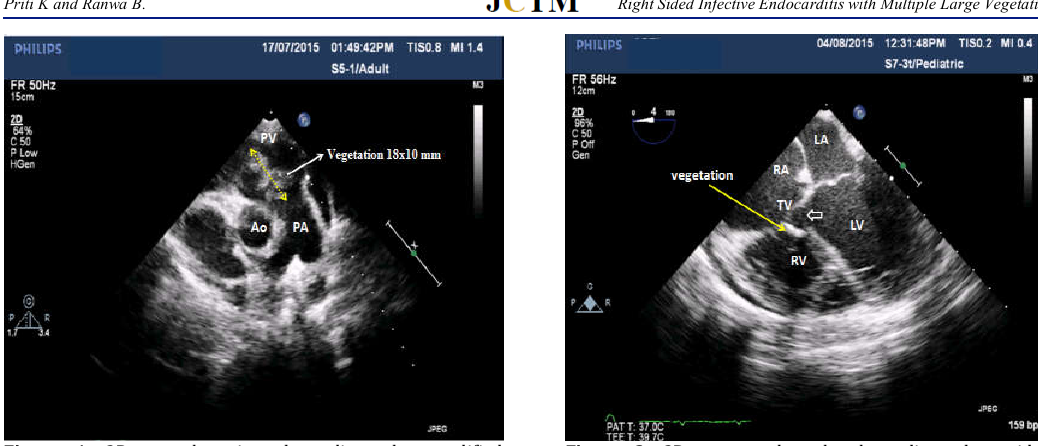
Figure 2. 2D transesophageal echocardiography, mideso- phageal 4-hamber view shows a large (12 mm×5 mm) mobile vegetation over the septal leaflet of tricuspid valve, perimembranous ventricular septal defect extends into inlet (open white arrow) (LA: left atrium, LV: left ventricle, RA: right atrium, RV: right ventricle, TV: tricuspid valve) vital role in establishing the diagnosis. A thorough echocardiographic evaluation of all cardiac valves, including right-sided valves is required in all the patients with suspected infective endocarditis. Isolated RSIE is regarded to have a relatively benign prognosis with low in-hospital mortality rate. It resolves conservatively in 70–85% of cases. Surgery is required in only a small population (8, 9). In the absence of the left-sided infective endocarditis coexistence, the surgery should be considered in the presence of diuretic resistance in the right-sided heart failure associated with severe tricuspid regurgitation, infection with fastidious organisms resistant to antimicrobial treatment, and vegetations with diameter of >20 mm along